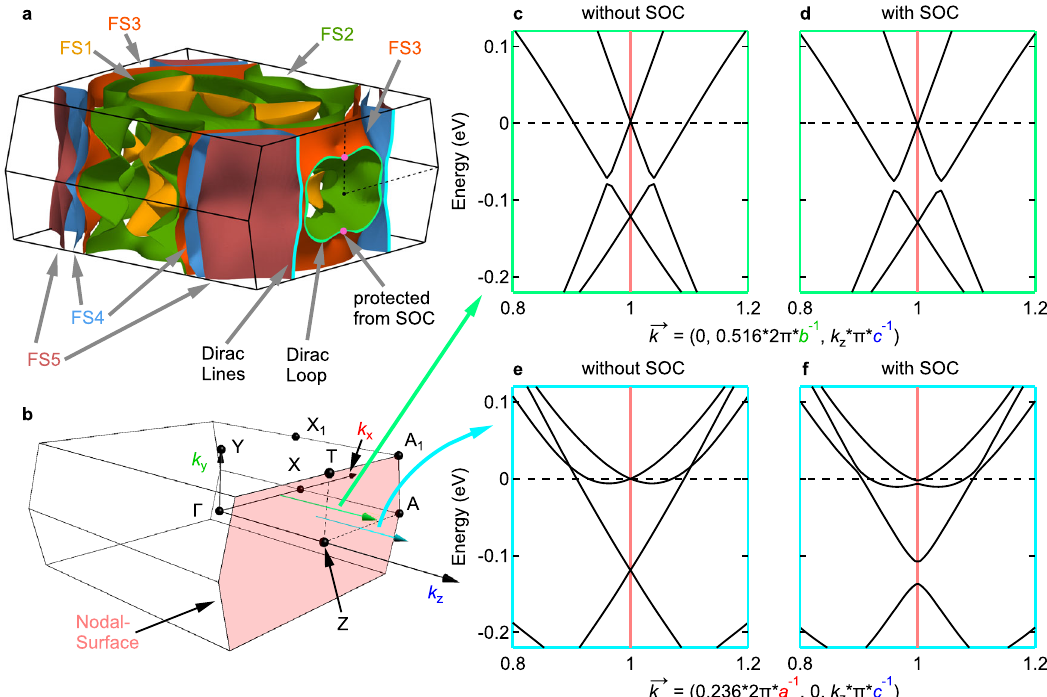
Fig. 2 Fermi surfaces and Dirac band crossings. a The fi ve Fermi surfaces (FSs), labeled as FS1 − 5, within the Brillouin zone (BZ). The Dirac lines (blue lines) and Dirac loop (green line) are highlighted on the nodal surface. The crossings along Z − T (magenta dots) are protected from spin-orbit coupling (SOC). b The BZ showing several high symmetry points and highlights the nodal surface (red plane). The green arrow, k y = 0.516*2 π / b , shows where FSs 2 and 3 become degenerate on the nodal surface. The Dirac crossing is shown to remain both without c and with SOC d , where the SOC contribution to anticrossing is seen to be very small. The blue arrow shows the dispersion along k x = 0.236*2 π / a without SOC e shows the Dirac lines between FSs 4 and 5. Once SOC is added f , the crossing becomes gapped at the nodal